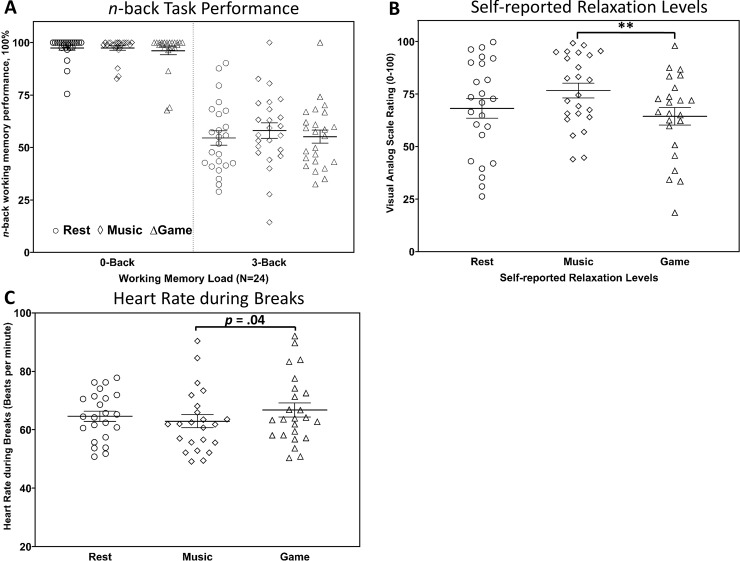
Scatterplots.**p < .0166. Please note that p < .0166 indicates the significance threshold after applying Bonferroni-correction for three comparisons. Horizontal lines in the scatterplots indicate means. Error bars represent standard errors of the mean. (A) Task performance in n-back as a function of memory load (0-back vs. 3-back) and break activity (game vs. music vs. rest). (B) Self-reported relaxation levels on visual analogue scores for game, music, and rest conditions. Visual analogue scales (VAS) were adapted from Bond & Lader (1974). (C) Heart rate during game, music, and rest conditions.